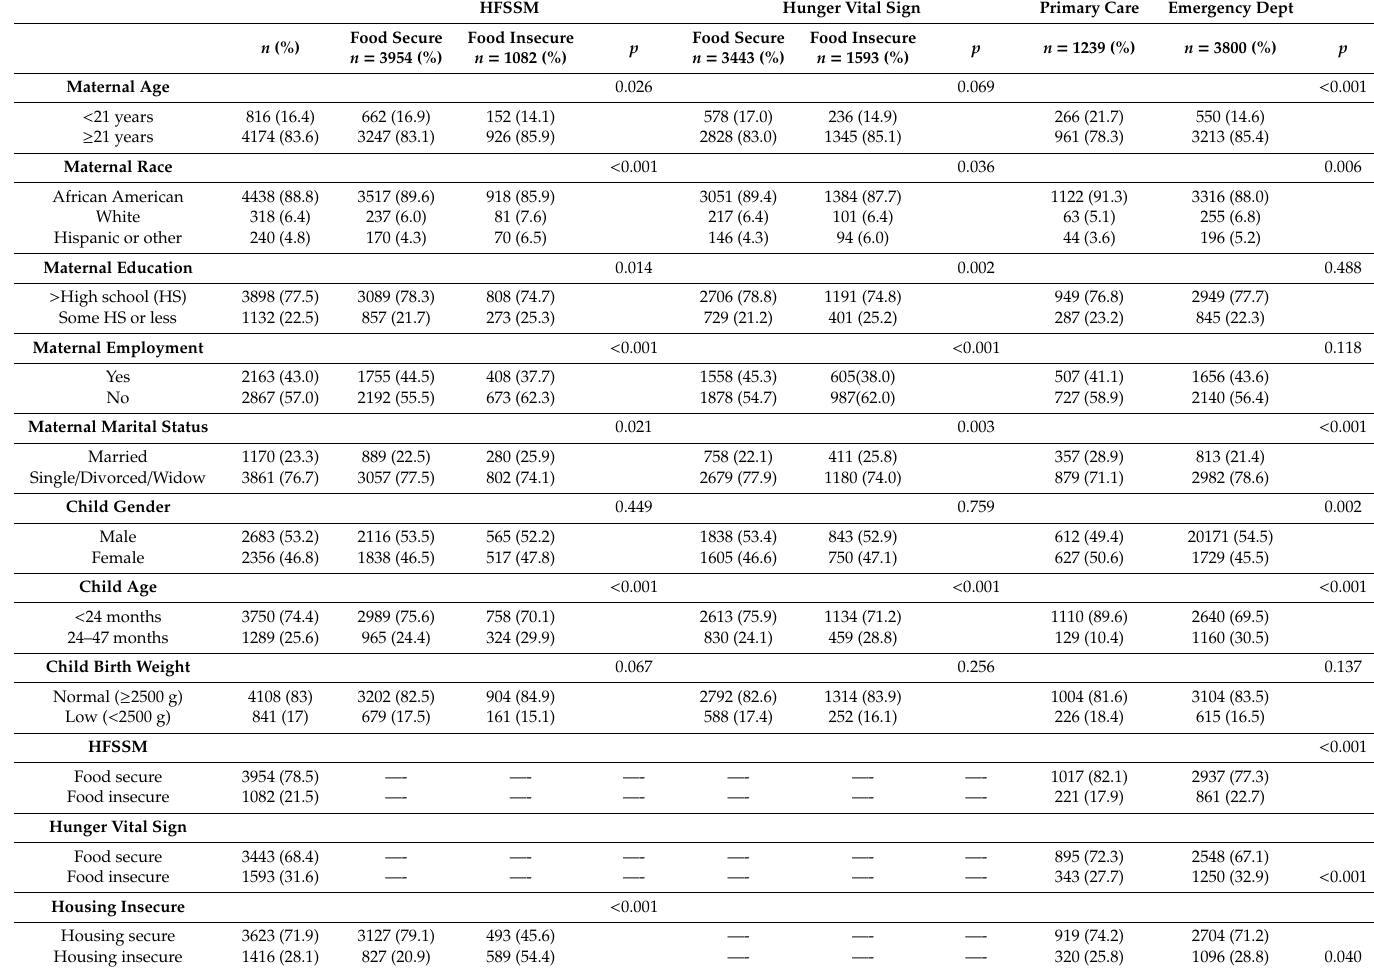
Table 1. Demographic information by food insecurity and health care site ( n = 5039) 1